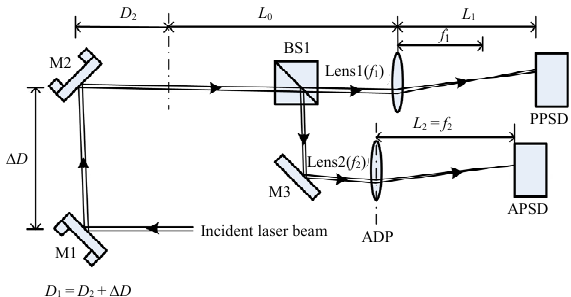
Fig. 1 Optical layout of the automated beam alignment system used for